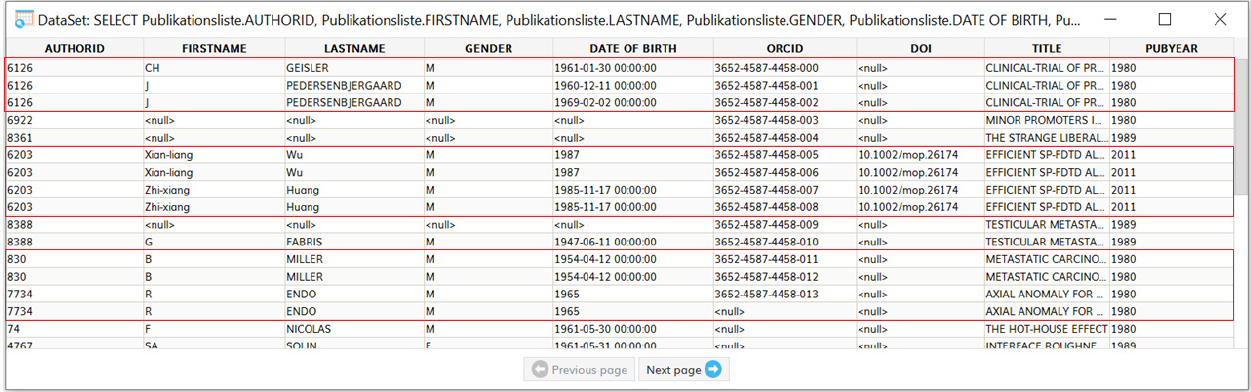
Figure 1. Examples of